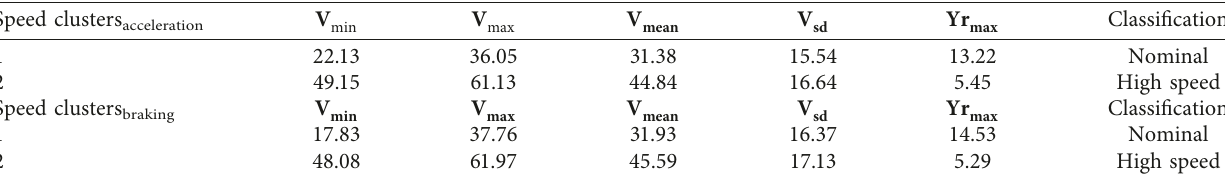
Figure 8: Bi-plots of speed clusters identified in (a) acceleration maneuvers (b) braking maneuvers. Table 8: Speed cluster centers for acceleration and braking maneuvers.